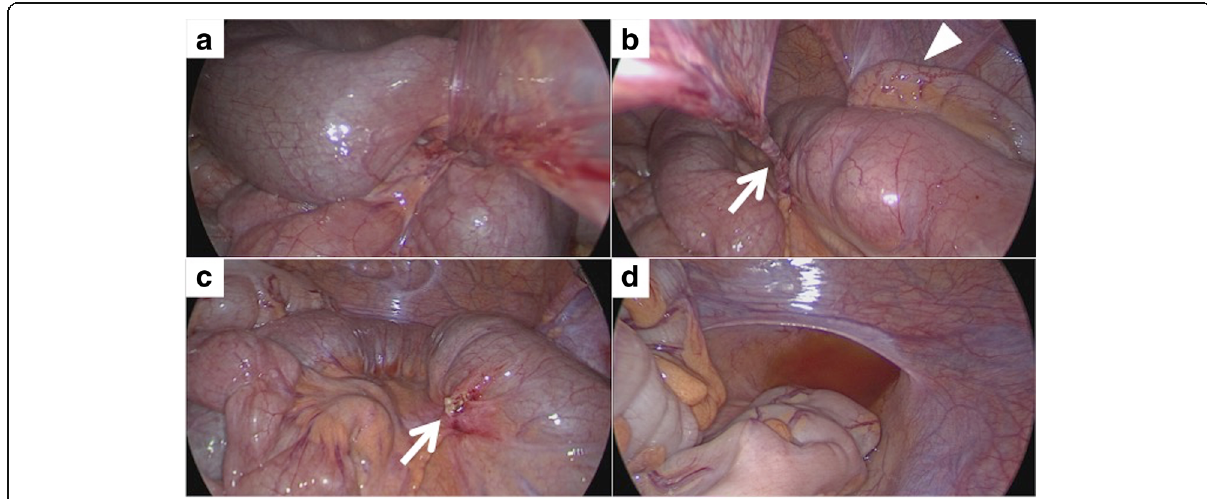
Fig. 2 Intraoperative findings. a The ileum was trapped and strangulated by a band. b After reduction. The band was connecting the right medial umbilical fold to the ileal mesentery (arrow). Slight inflammatory change was observed on the surface of the appendix (arrowhead). c The band was connected to the ileal mesentery, 30 cm proximal to the ileocecal valve. Meckel ’ s diverticulum was not detected. The trapped ileum showed no ischemic change. d Serous ascites was observed at the recto-vesical pouch